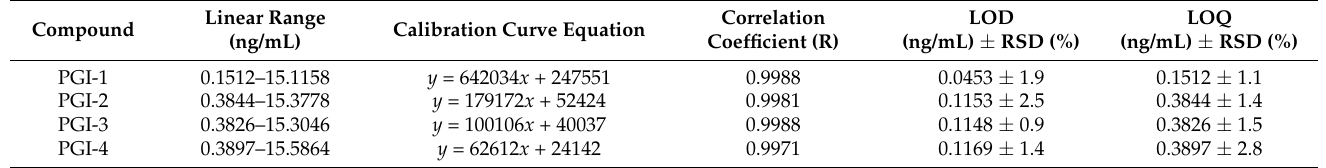
Table 1. LOD, LOQ, and linear regression equation of PGI-1, PGI-2, PGI-3, and PGI-4. Linear Range Compound